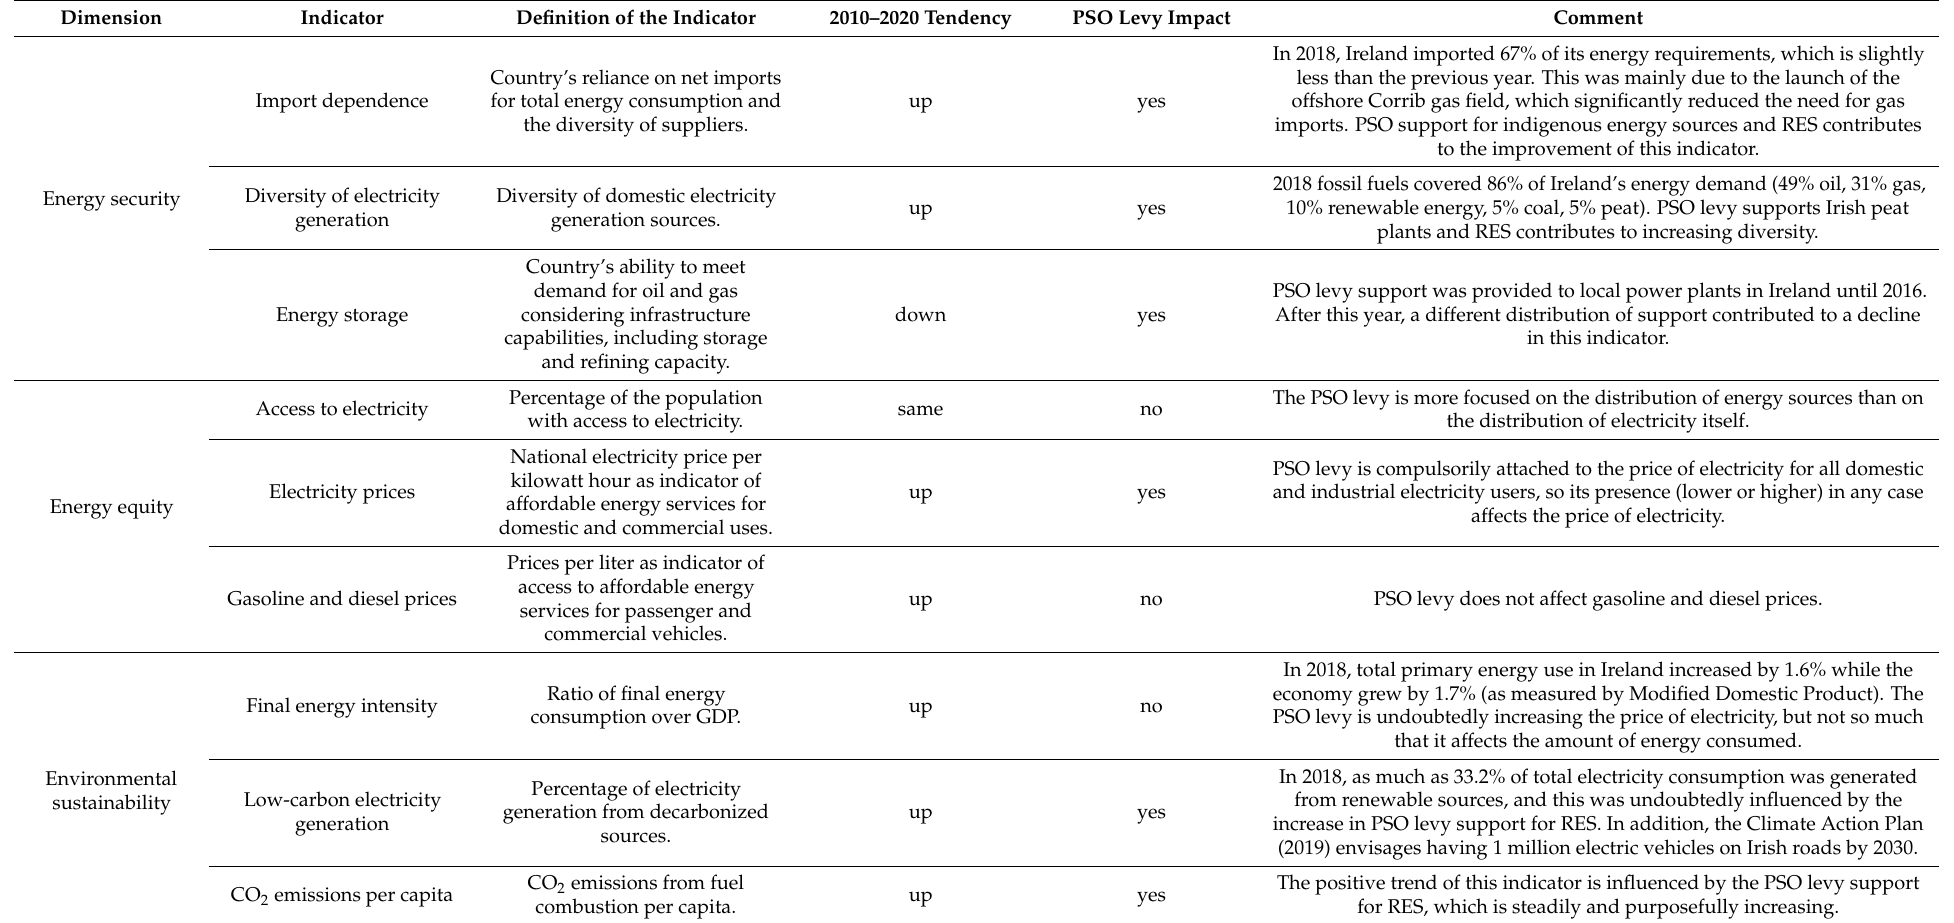
Table 3. PSO levy impact on Energy Trilemma Index for Ireland (created by the authors, based on